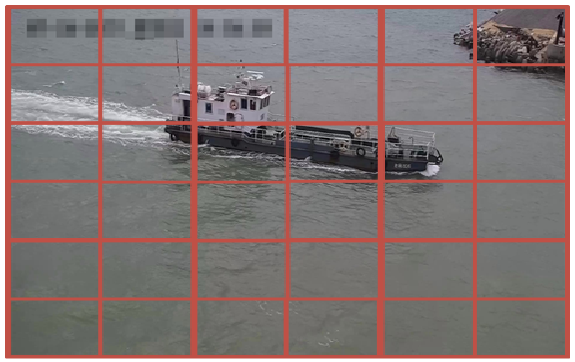
Figure 2. Region proposal of